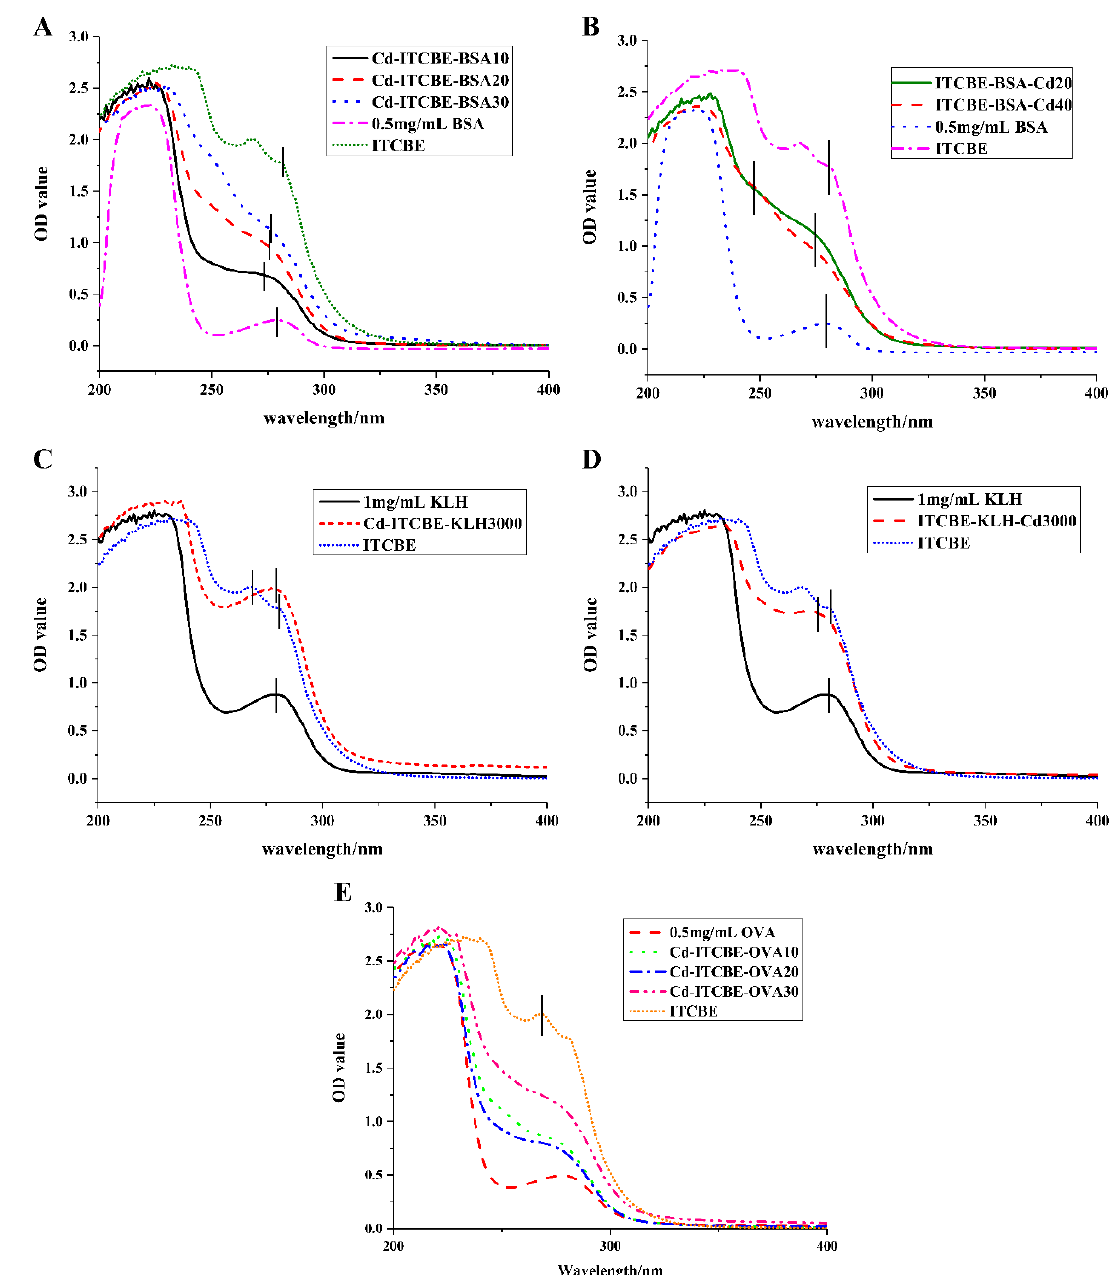
Figure 2. Complete antigens for Cd 2+ were identified by ultraviolet spectrophotometry. ( A ) The immune antigens against Cd 2+ based on BSA and method 1; ( B ) The immune antigens against Cd 2+ based on BSA and method 2; ( C ) The immune antigens against Cd 2+ based on KLH and method 1; ( D ) The immune antigens against Cd 2+ based on KLH and method 2; ( E ) Coating antigens for Cd 2+ .